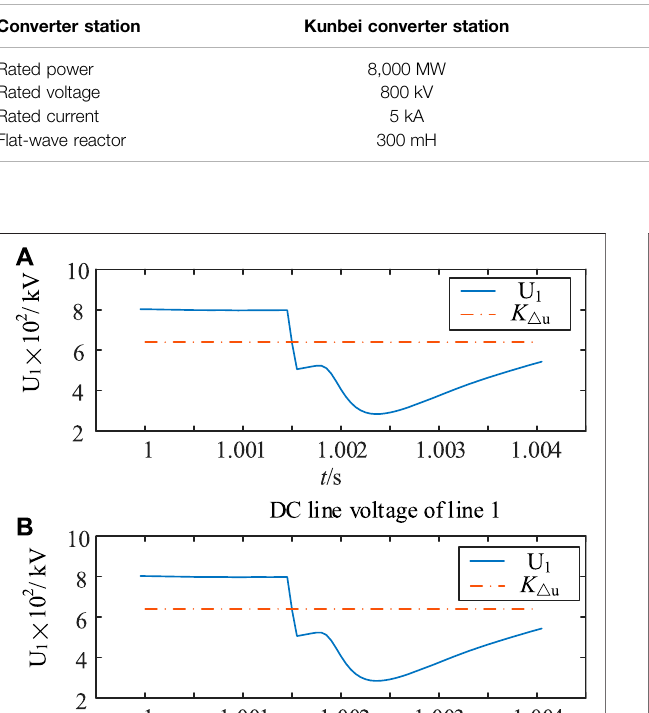
TABLE 1 | Main parameters of the simulation system.